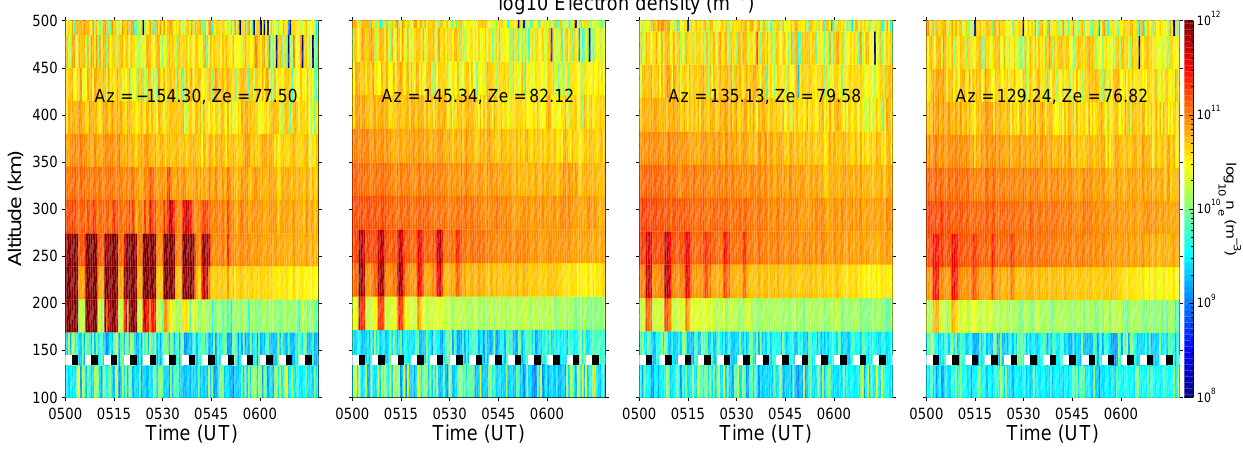
Fig. 1. The four panels shows the Poker Flat Incoherent Scatter Radar observations of electron densities in the 4 look directions. The white and black bars mark the pulsed and CW heating periods,